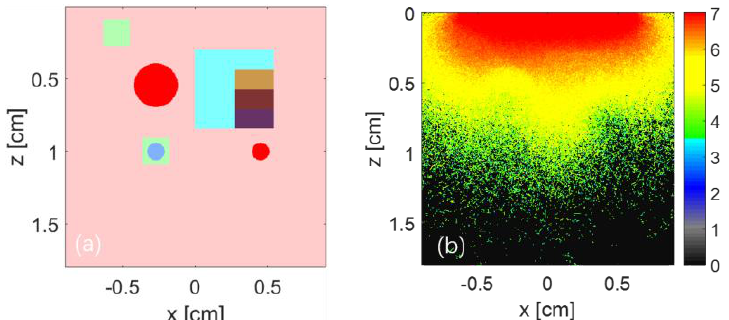
Figure 3. ( a ) The z-x section diagram of the tissue model, different objects are distinguished by different colors and shapes; ( b ) Pure background tissue fluence distribution. The axes z and x (left and bottom) illustrate the spatial scale, the unit is cm, whereas the color scale (right) unit is mJ/cm 2 .